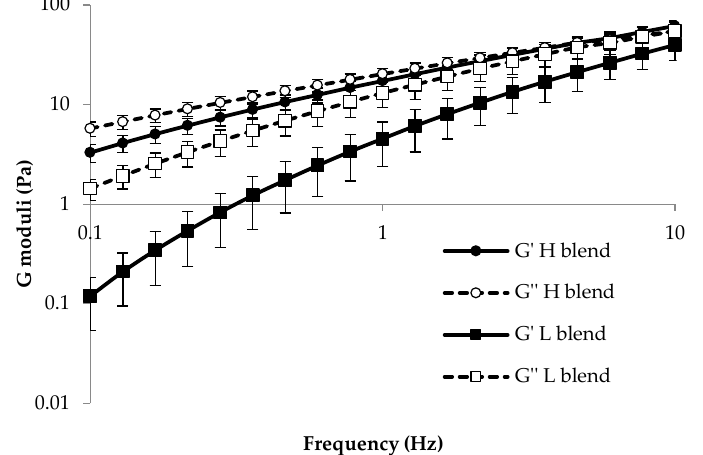
Figure 4. G′ and G″ profiles of H and L (mean values ± SD.; n = 3). Figure 4. G (cid:48) and G” profiles of H and L (mean values ± SD.; n =